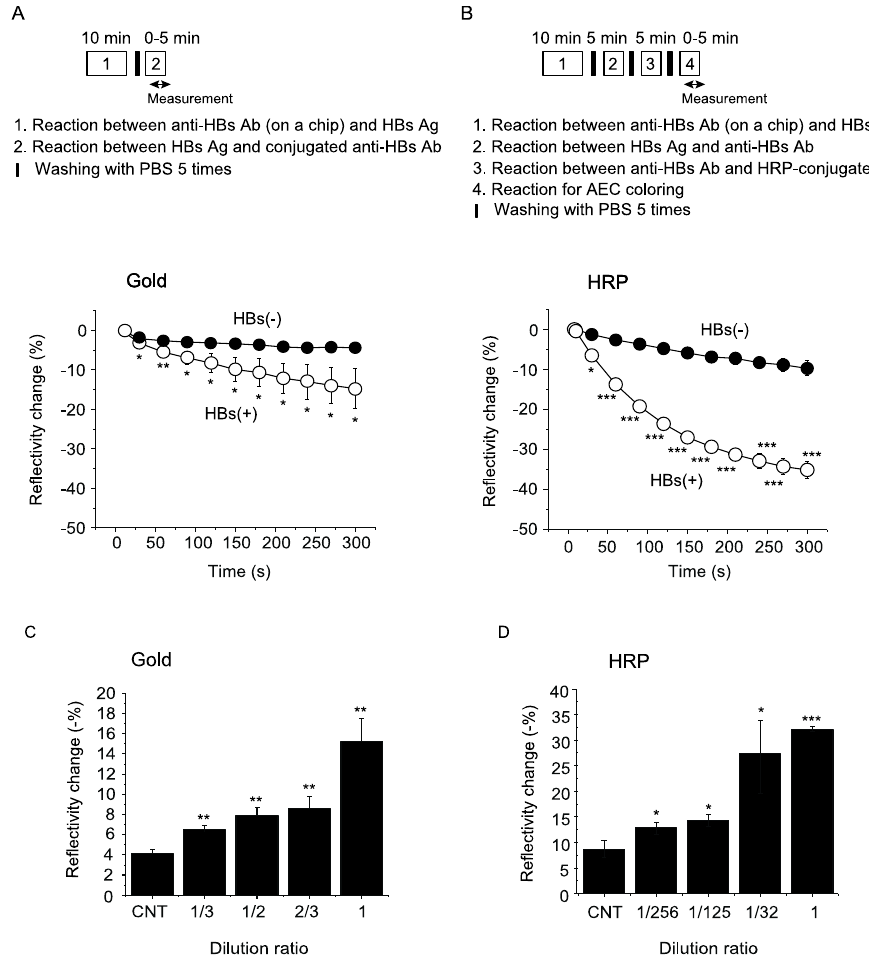
Figure 5. Detection of HBs antigen with a WM sensor. ( A ) Signal enhancement using gold nanoparticle-conjugated antibody. ( B ) Signal enhancement using HRP-conjugated antibody. Comparison of detection sensitivity of signal enhancement using gold nanoparticles ( C ) and a peroxidase reaction ( D ). Changes in a dip of a spectrum were measured at the time point of 5 min (300 s). CNT, control plasma. Plasma positive for HBs antigen were diluted in indicated ratios. * p < 0.05, ** p < 0.01, *** p < 0.001 versus control plasma (n = 3 − 4 for each group).